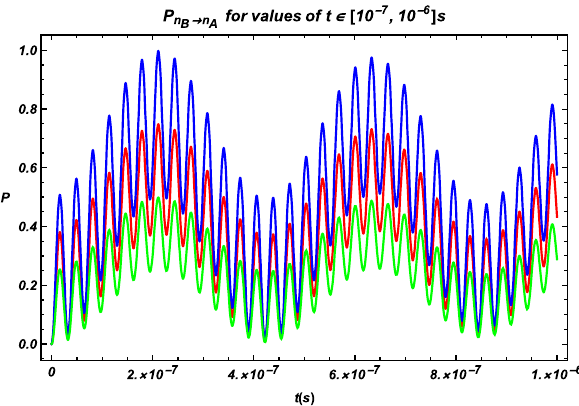
Fig. 3 Plots of P B → A ( t ) , for θ = π/ 3 (the red line), θ = π/ 4 (the blue line), θ = π/ 8 (the green line). In the plots, we consider n = 4 trapped ions in an anharmonic potential, and the follow- ing values of the resonance frequencies of the atomic spins splitting (cid:14)ω / 2 π( MHz ) = − 30 . 7 ; − 2 . 3 ; 2 . 4 ; 30 . 9, and of the coupling con- i stant J ij ( Hz ) : J 1 , 2 = 2 . 1 ; J 1 , 3 = 1 . 8; J 1 , 4 = 0 . 4 ; J 2 , 3 = 123 . 8, with J 3 , 4 = J 2 , 4